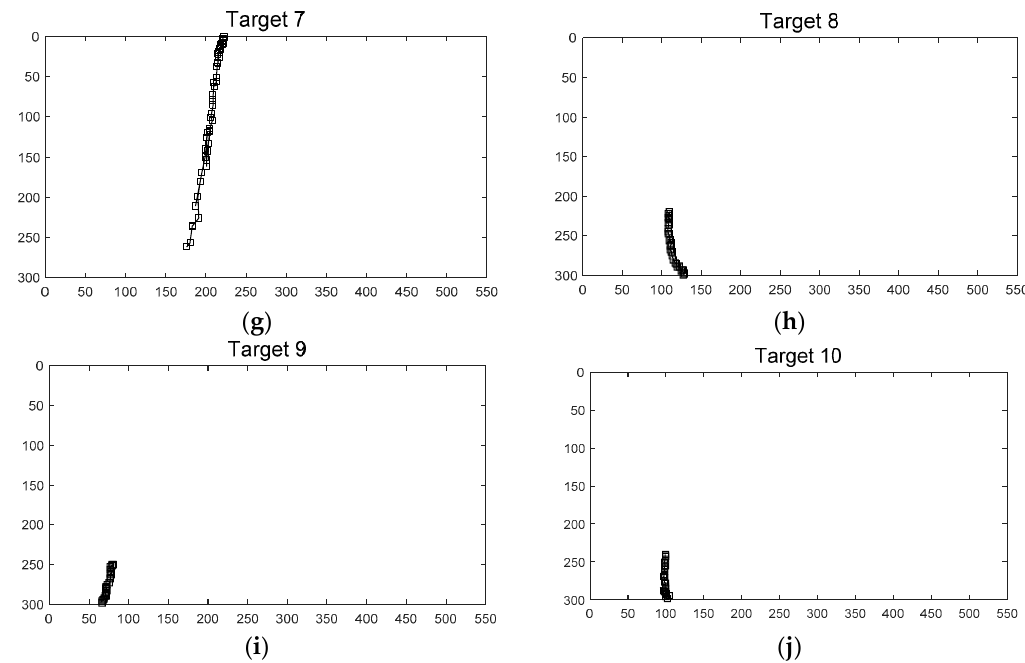
Figure 12. Ground truth of position, ( a ) Target 1, ( b ) Target 2, ( c ) Target 3, ( d ) Target 4, ( e ) Target 5,